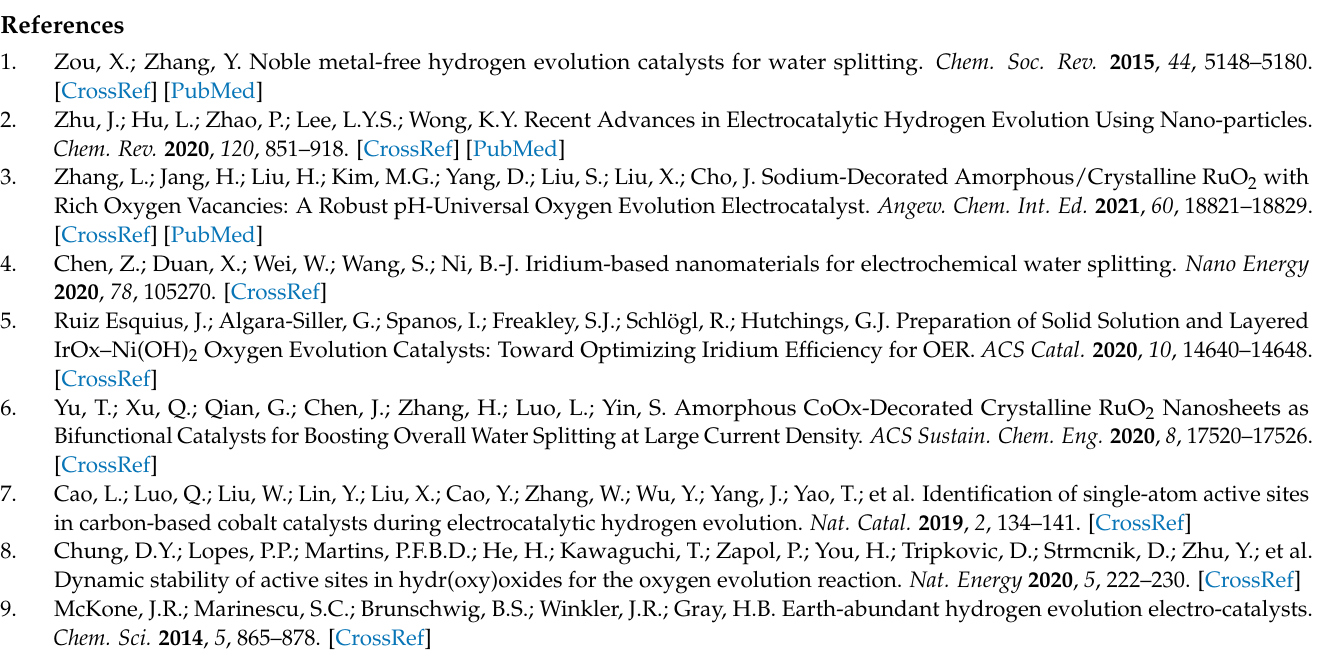
(a) SEM images of ZIF-67. (b,c) SEM images and d) EDX spectrum CoP. Figure S5: (a–d) TEM image of CoMoP. Figure S6: (a–d) HAADF-STEM micrographs of CoMoP. Figure S7: EELS chemical composition maps obtained from the red squared area of the STEM micrograph. Individual Co L2,3-edges at 779 eV (red), Mo M4,5-edges at 230 eV (green), P L2,3-edges at 132 eV (blue), N K-edge at 401 eV (pink) and C K-edge at 284 eV (orange). Figure S8: (a) OER and (b) HER polarization curves of CoMoP with different Mo content in 1.0 M KOH. Figure S9: Cyclic voltammograms for (a) CoMoP; (b) Mo–CoP; (c) CoP and (d) RuO2 in the non-faradaic region of 1.12–1.22 V vs. RHE at various scan rates. Figure S10: (a–c) SEM image and (d) EDX spectrum of CoMoP after long-term OER stability testing. Figure S11: (a–c) SEM image and (d) EDX spectrum of CoMoP after long-term HER stability testing. Table S1: Comparison of OER performance of CoMoP with some previously reported CoP-based catalysts in 1.0 M KOH solution. Table S2: Comparison of HER performance of CoMoP with some previously reported CoP-based catalysts in 1.0 M KOH solution. Table S3: Comparison of OWS performance of CoMoP with some previously reported CoP-based catalysts